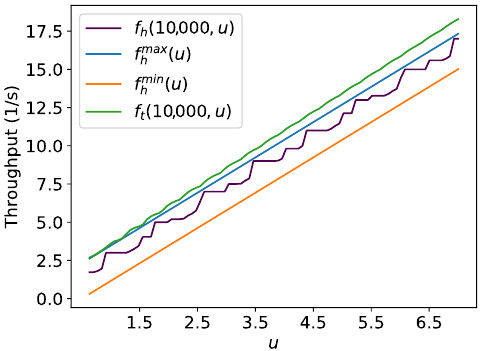
( u ) for all u , √ h 3,1.25].